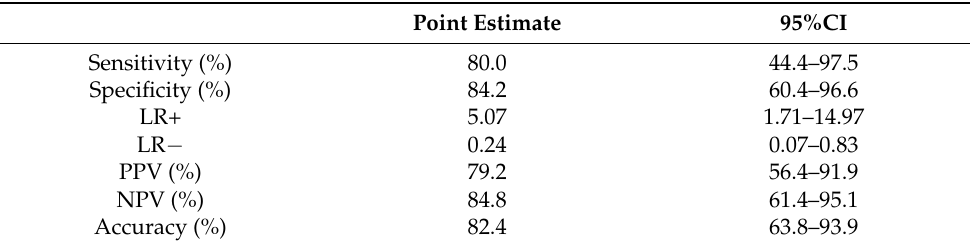
Table 3. Diagnostic test evaluation of maximal tricuspid regurgitant velocity >3.1 m / s at 20 µ g/kg/min of dobutamine infusion during stress echocardiography.